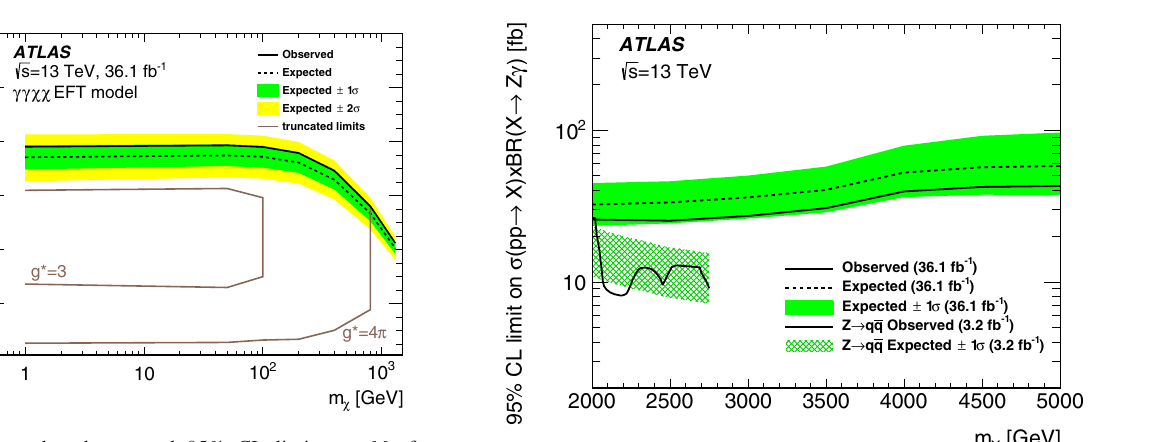
Fig. 6 The observed and expected 95% CL limits on M ∗ for a dimension-7 operator EFT model with a contact interaction of type γγχχ asafunctionofdark-mattermass m χ .ResultswhereEFTtrunca- tion is applied are also shown, assuming representative coupling values, g ∗ , of 3 and 4 π : for the maximal coupling value of 4 π , the truncation has almost no effect; for lower coupling values, the exclusion limits are confined to a smaller area of the parameter space